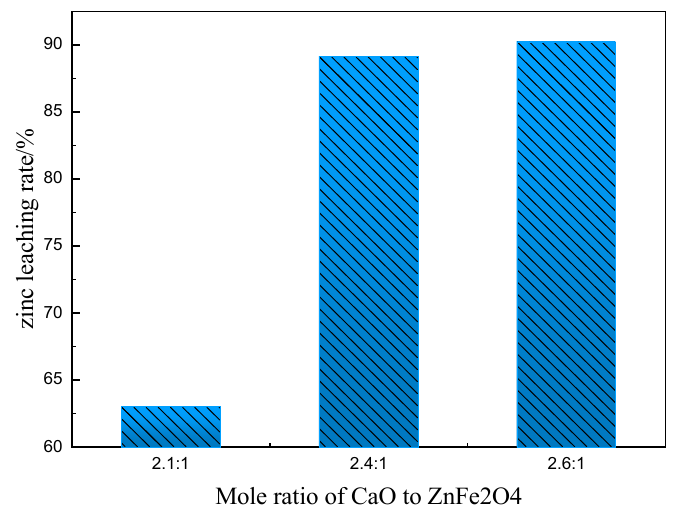
Figure 10. Effect of CaO/ZnFe 2 O 4 (mole ratio) on zinc leaching rate.